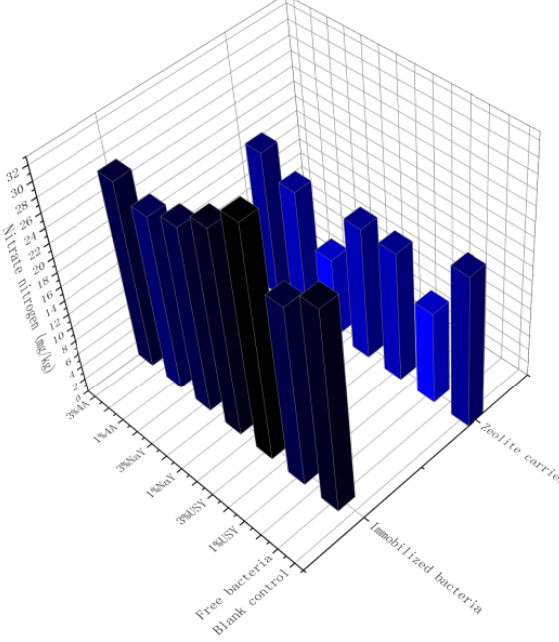
Figure 4. The effect of zeolite and bacteria on soil nitrate nitrogen.